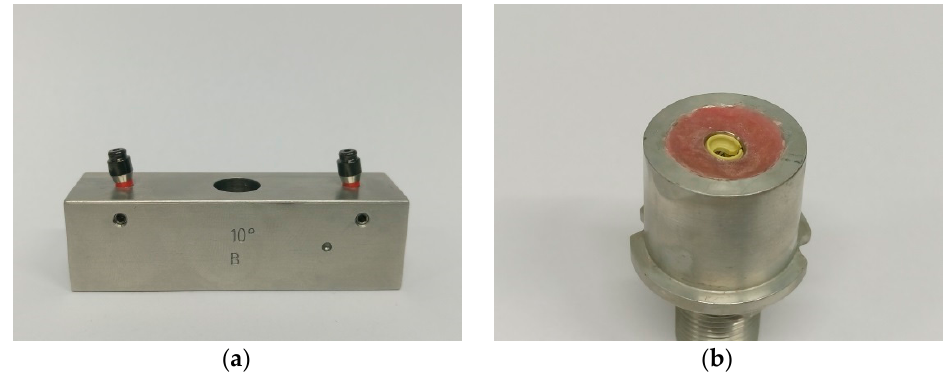
Figure 1 . ( a ) Part 1: metal block—analog or abutment holder; ( b ) part 2: PMMA base material with matrix holder and matrix; example shown: implant angulation—10° with the Novaloc attachment system—0° and yellow matrix.